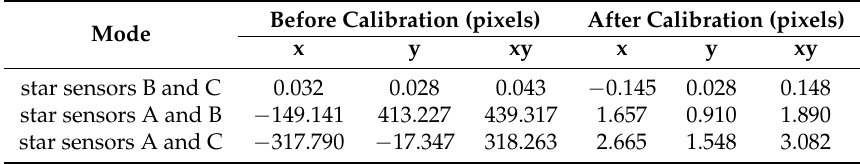
Table 8. The geometric accuracy improvement for different star sensor combined modes. Before Calibration (pixels) After Calibration (pixels) Mode